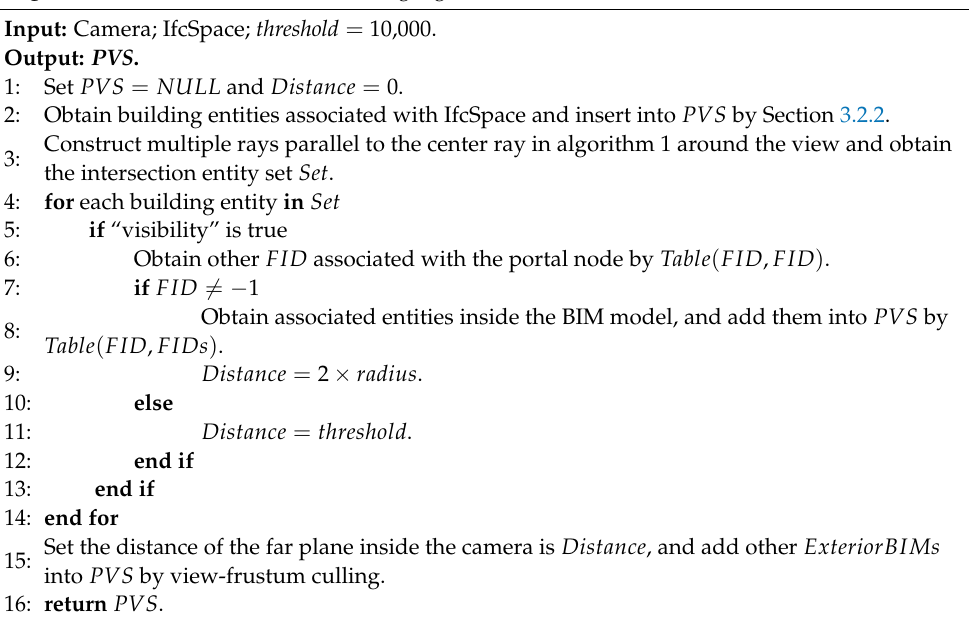
Algorithm 2. Semantic-based scheduling algorithm for indoor